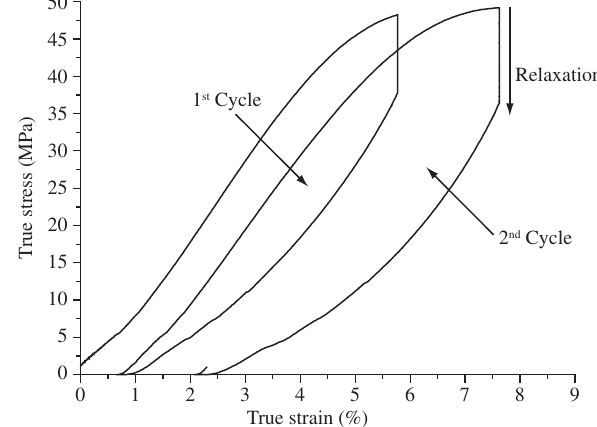
Figure 15. Stress-strain curve for two cycles.